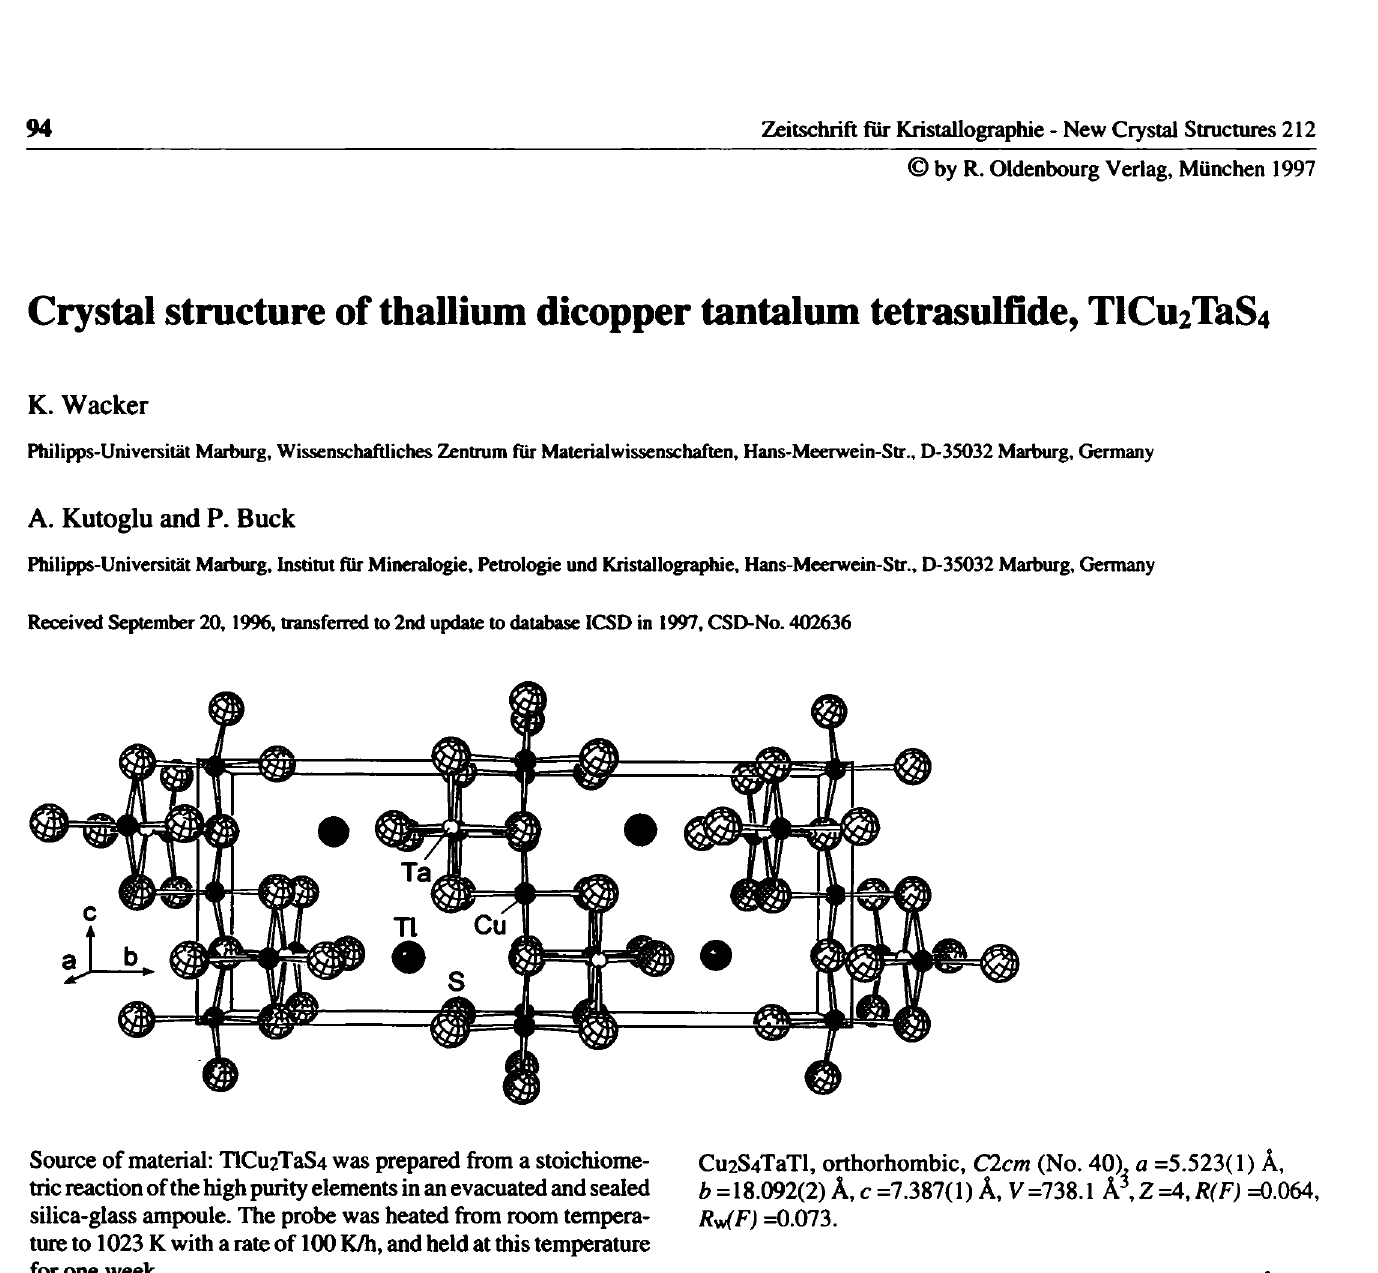
Table 2. Final atomic coordinates and displacement parameters (in Â 2 ) Atom Site X